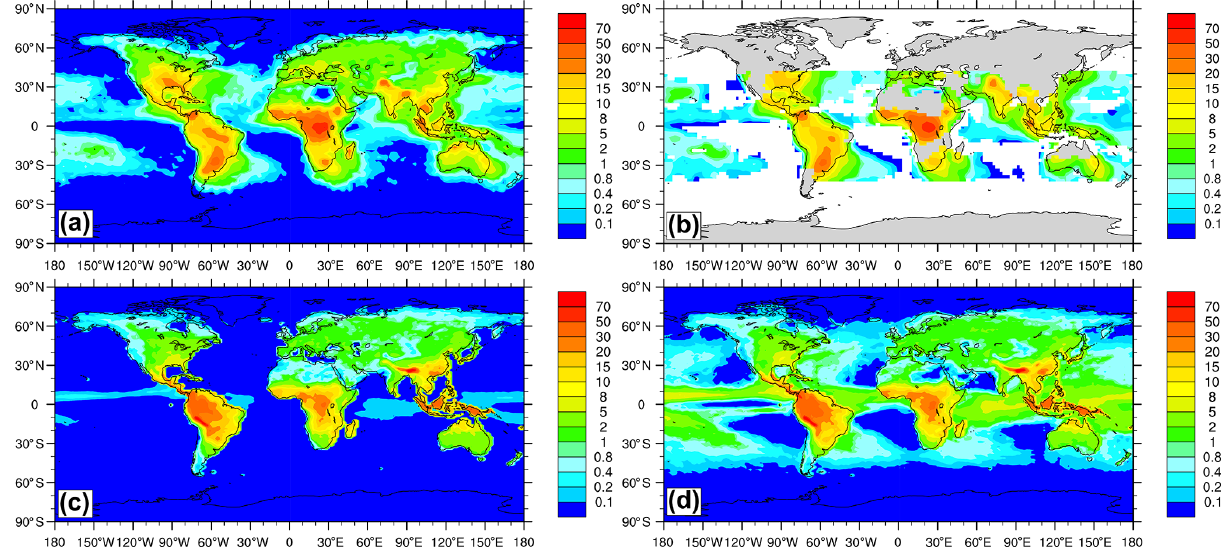
Figure 5. Global distribution of the mean annual lightning flash density (flasheskm − 2 yr − 1 ): (a) LIS/OTD satellite climatology, (b) LIS satellite data for the year 2006 (available only for ± 42 . 5 ◦ latitudes), (c) model simulation with the default PR92 flash-rate parameterisations (Run 1), and (d) model simulation with the new flash-rate parameterisations from this study (Run 2). Table 3. NMSE, FB, and r for the spatially varying annual-mean modelled flash rates and observed climatology shown in Fig. 5a. Flash-rate scheme NMSE FB Spatial correlation ( r ) Globe Land Ocean Globe Land Ocean Globe Land Ocean Run 1 (PR92) 4.52 1.63 164.92 0.44 0.27 1.84 0.72 0.74 0.41 Run 2 (TS1) 3.66 1.66 6.77 0.13 0.18 − 0 . 06 0.72 0.74 0.38 Run 3 (TS2) 3.63 1.65 6.92 0.21 0.28 − 0 . 06 0.72 0.74 0.38 Run 4 (Mi99) 3.44 1.63 6.68 0.17 0.30 − 0 . 30 0.72 0.74 0.39 Run 5 (Bo02) 3.58 1.76 8.56 0.01 0.28 − 0 . 76 0.68 0.72